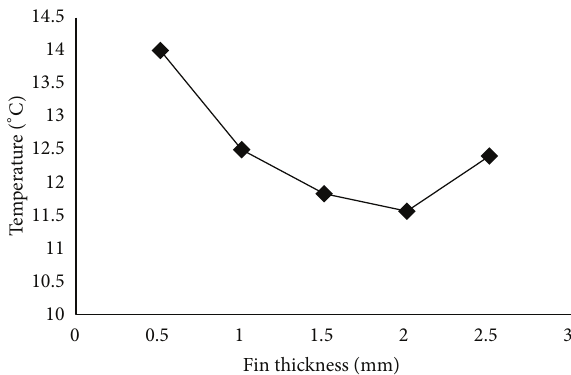
Figure 4: Relationship between the thickness of hollow fins and the temperature difference among